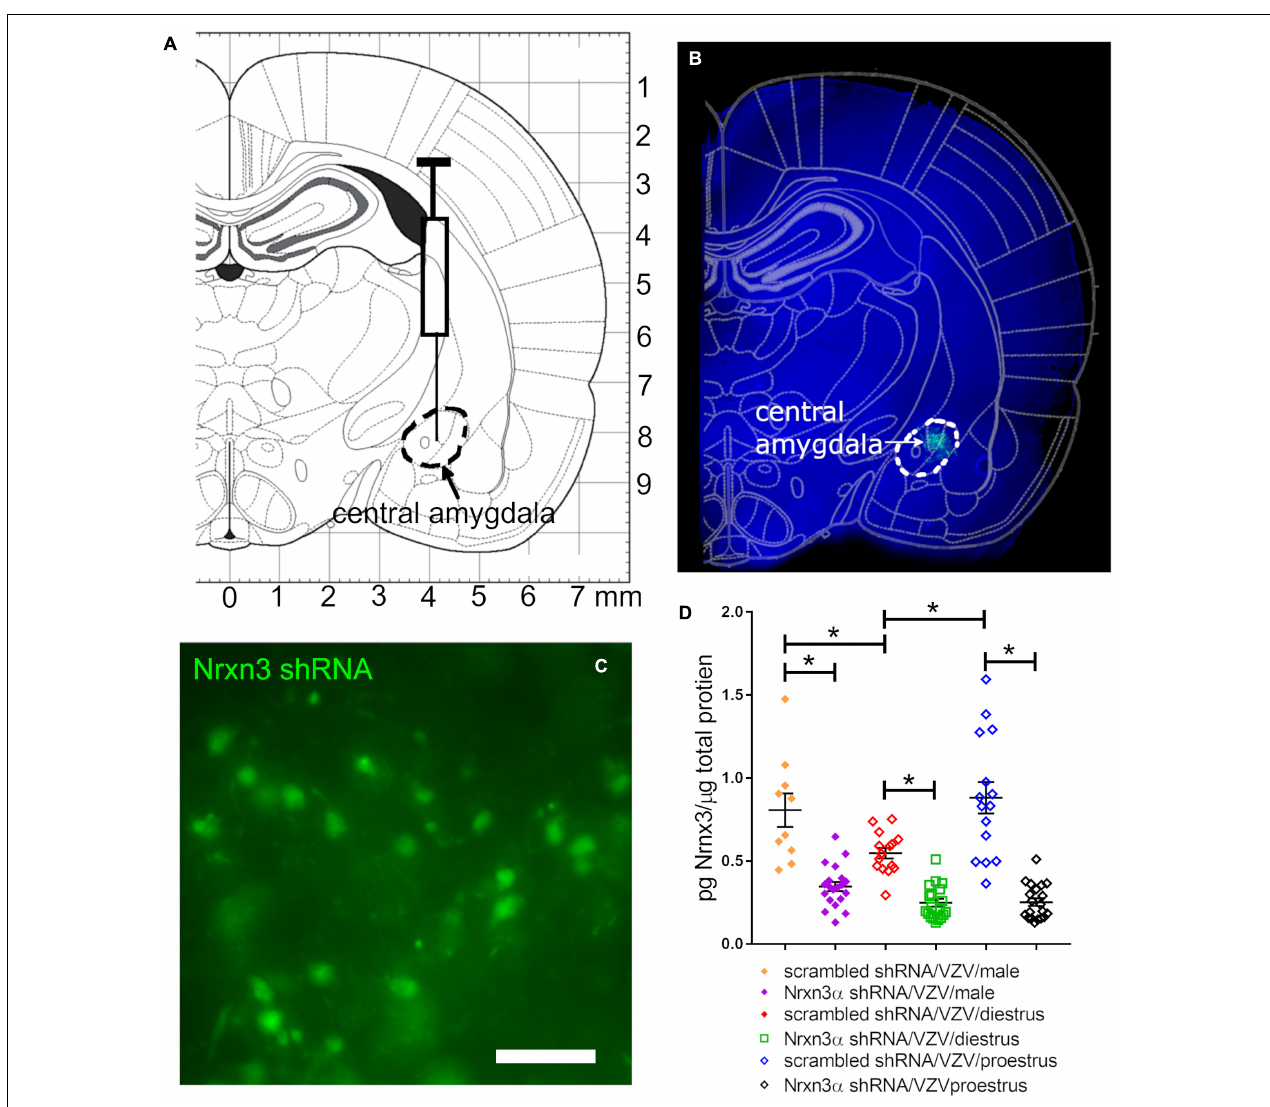
FIGURE 1 | Lentivirus was injected in the central amygdala of Long Evans rats and produced NRXN3 α shRNA that attenuated expression. (A) Shows an atlas image for infusion of the central amygdala indicated by a dashed black line. (B) Shows a 30 mm thick section from a representative female rat having GFP expression (green) within the central amygdala 6 weeks after infusion of lentivirus containing pGFP-C-shLenti Nrxn3 shRNA. (C) Is a high magnification image of GFP positive cells within the central amygdala. Bar = 50 µ m. (D) Is a histogram of Nrxn3 α protein expression in the right central amygdala using ELISA analysis. Nrxn3 α expression was quantitated after infusion of either scrambled (control) shRNA or Nrxn3 α shRNA and injection of VZV in the left vibrissae pad. Each point on the histogram represents an individual animal and the asterisk indicates p <